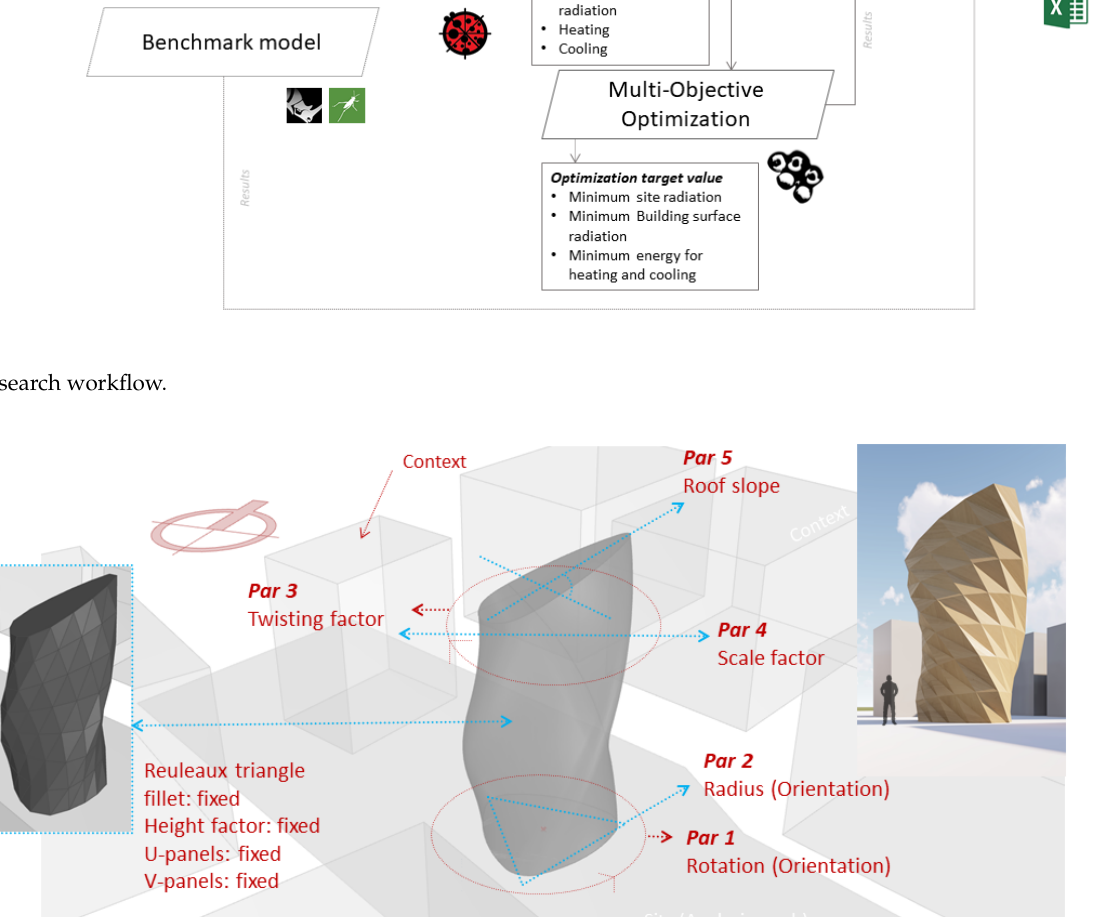
units to 25 units. The last design variable is the roof slope. This variable has 12 variable’s movements with the 5 ◦ unit for each step. The parameters ranged from a minimum an- gle of 0 ◦ to 30 ◦ . Besides the dynamic parameters, the fixed parameters are set. The fixed parameters are the triangle’s fillet, height factor, U and V axis for planar paneling.